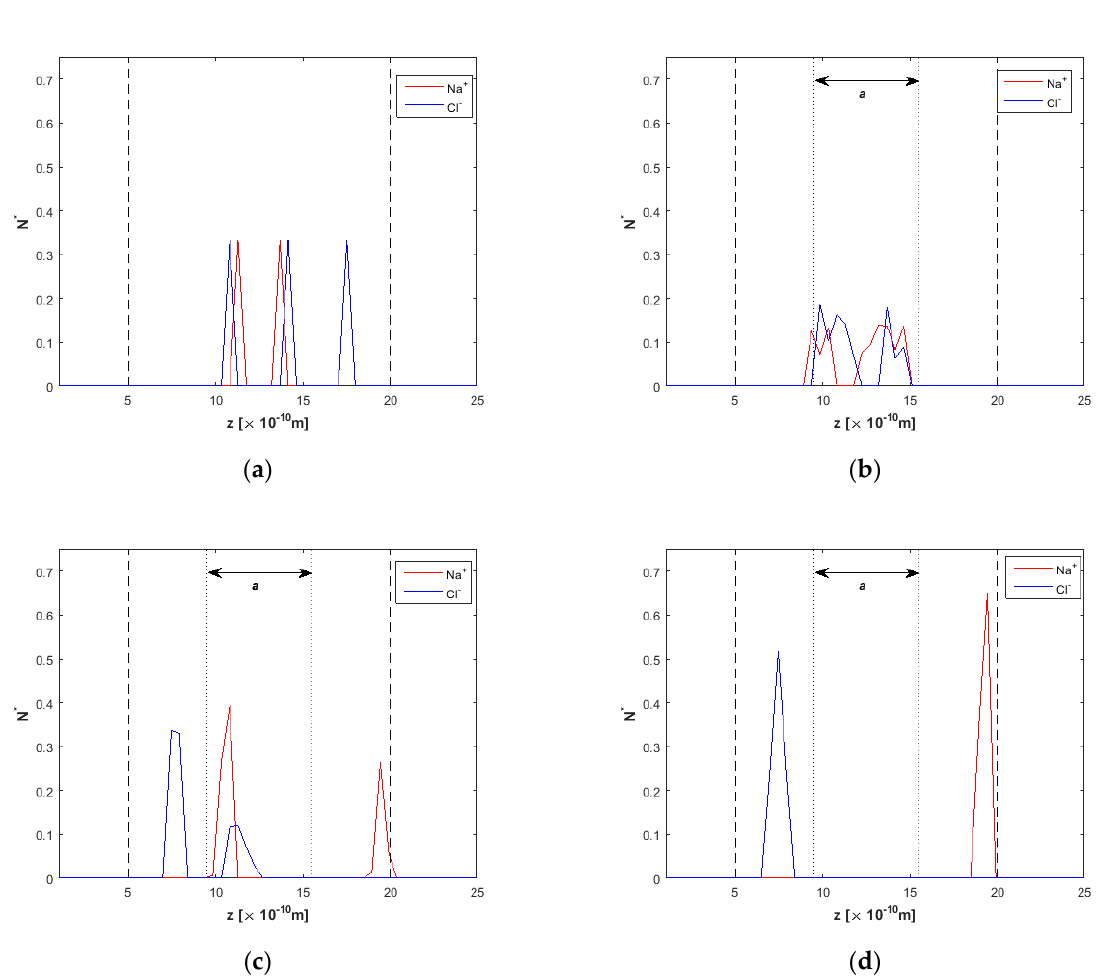
Figure 5. Ion concentration across the h = 1.5 nm nanochannel at various times of the simulation, F ext = 0.025 kcal / molÅ, ( a ) t = 5 ns, E = 0.0 V / Å, ( b ) t = 8 ns, E = 2.0 V / Å, ( c ) t = 15 ns, E = 2.0 V / Å, and ( d ) t = 20 ns, E = 2.0 V / Å. Dashed lines denote wall limits and dotted lines enclose the desired clean water region.